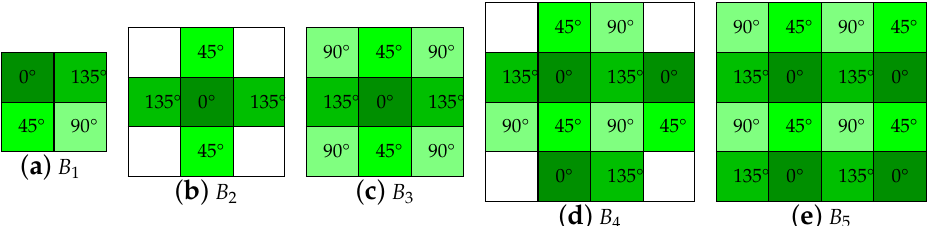
Figure 5. The five demosaicking kernels of the five bilinear methods B 1 − 5 from the work by Ratliff et al. [34]. It refers to the neighborhood used for interpolation. ( a – c ) Are simple bilinear kernels, whereas ( d , e ) are weighted bilinear